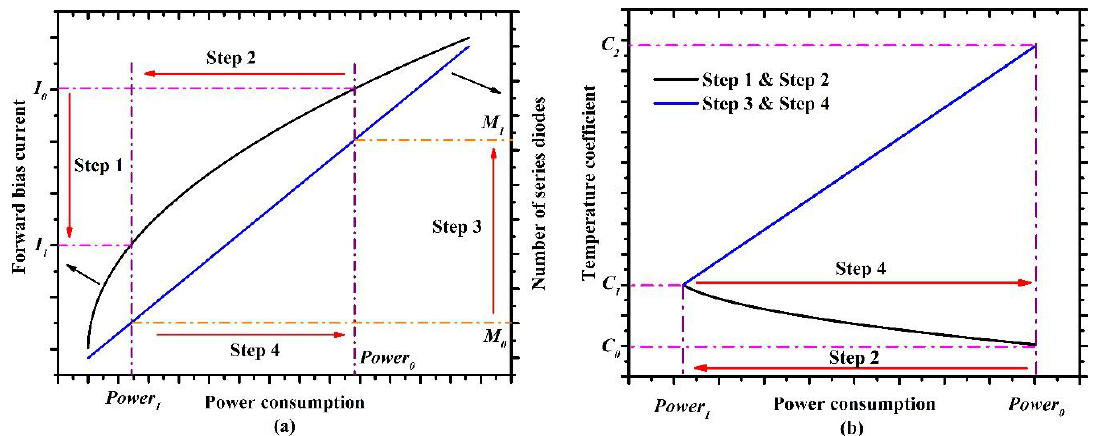
Figure 4. ( a ) Detailed process of obtaining a greater temperature coefficient with the same power consumption. ( b ) Temperature coefficient is improved from C 0 to C 1 by reducing the forward bias current and is further improved from C 1 to C 2 by increasing the number of series diodes.